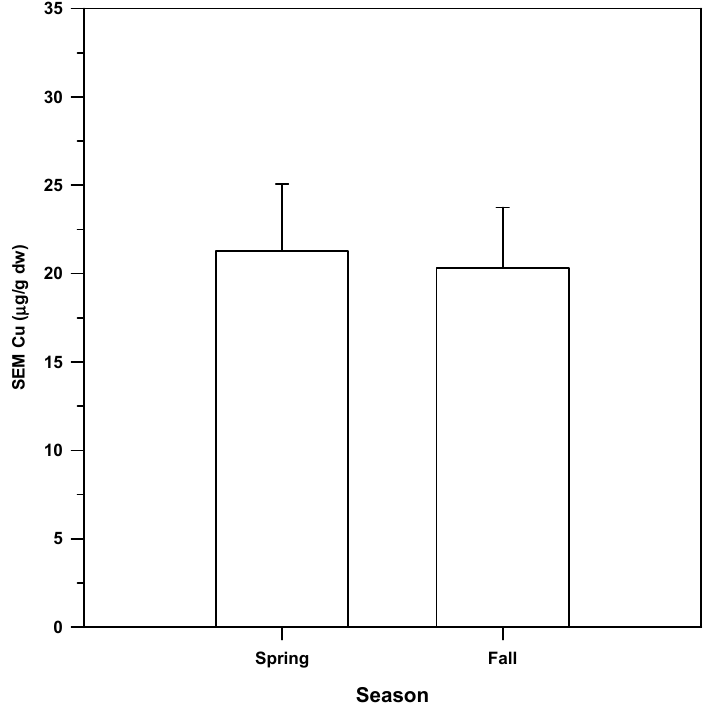
Figure 20. All Cache Slough SEM Cu sediment data for the year 2013 by season ( t -test, p = 0.716).